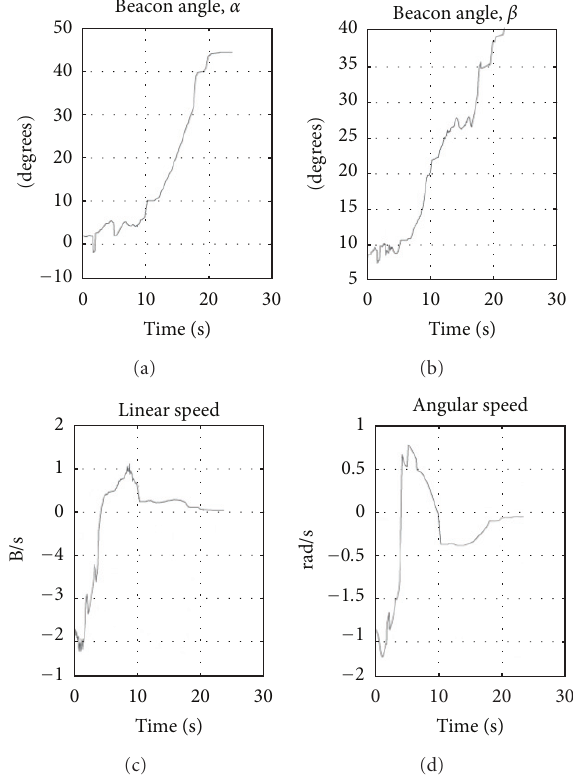
Figure 19: The changes in α , β , and the control signals for the forth experiment.